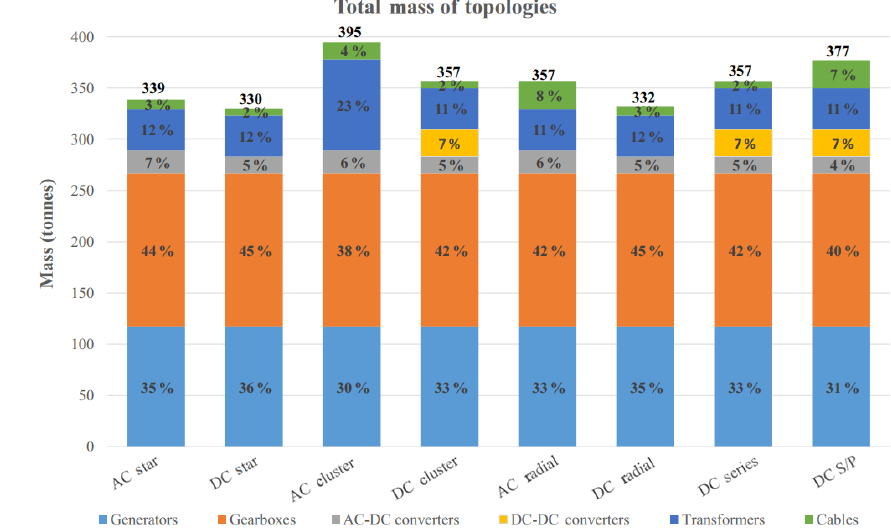
Figure 12. Total mass of electrical topologies with breakdown by